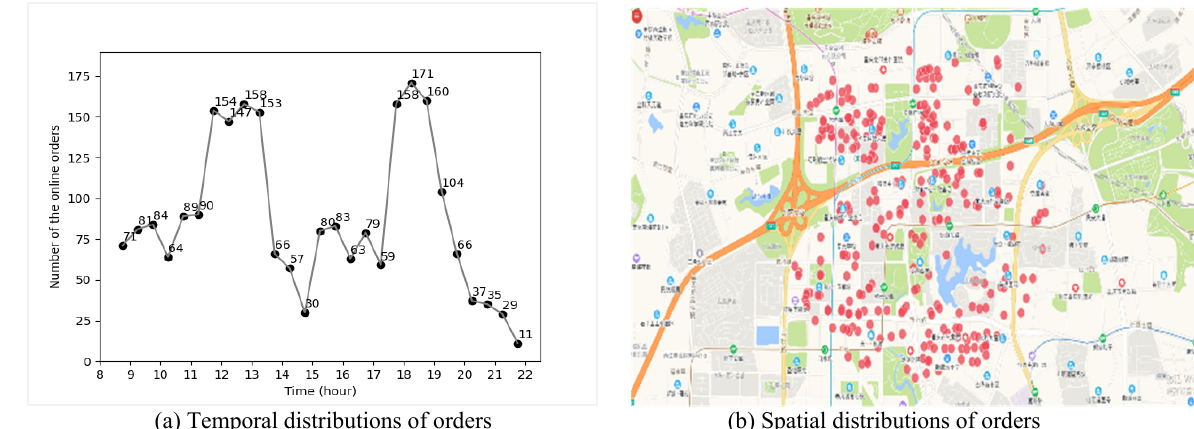
(a) Temporal distributions of orders (b) Spatial distributions of orders Fig. 5. Temporal and Spatial distributions of orders